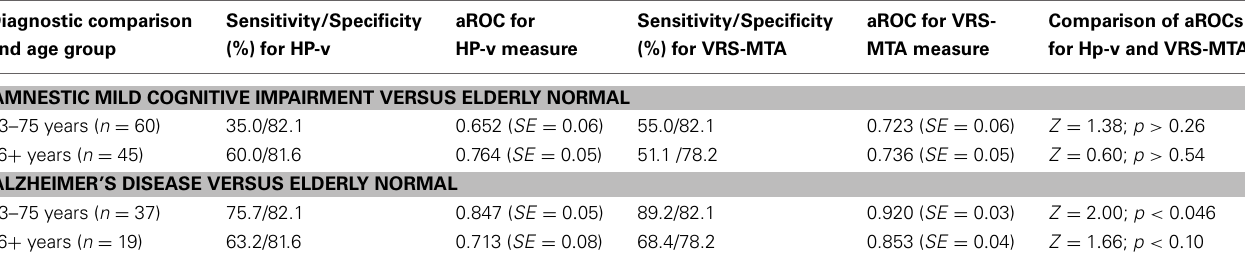
Table 2 | HP-v and VRS-MTA measures in the classification of subjects with Amnestic MCI and Alzheimer’s disease.